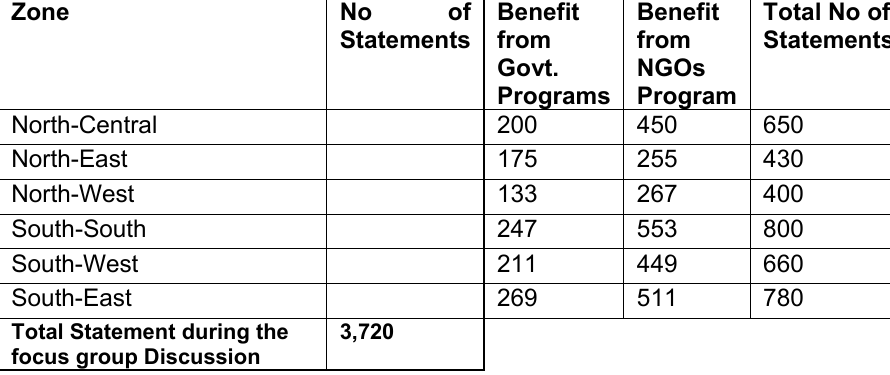
Table 9: Summary of Focus Group Respondents’ Statements Zone